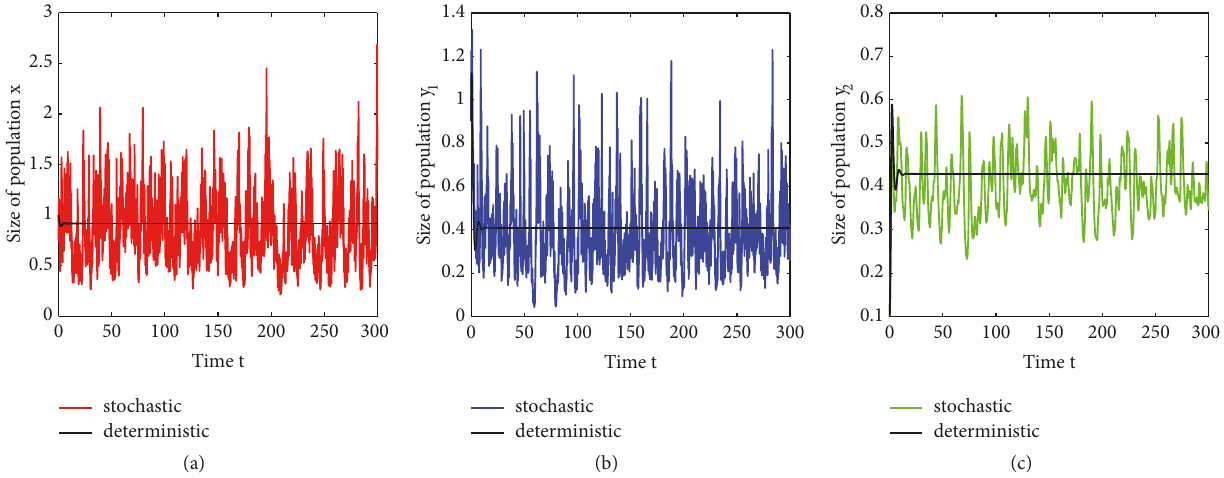
Figure 5: Numerical simulation of the solution of model (6). The parameters of model (6) are 𝑎 = 1 , 𝑏 = 1 , 𝑐 = 0.1 , 𝜂 = 0.1 , 𝑑 = 2 , ̂𝑒 = 0.1 , 𝑓 = 1 , 𝛿 = 2.5 , 𝑔 = 0.2 , 𝜎 = 0.5 , and 𝜎 = 0.5 . 1 2